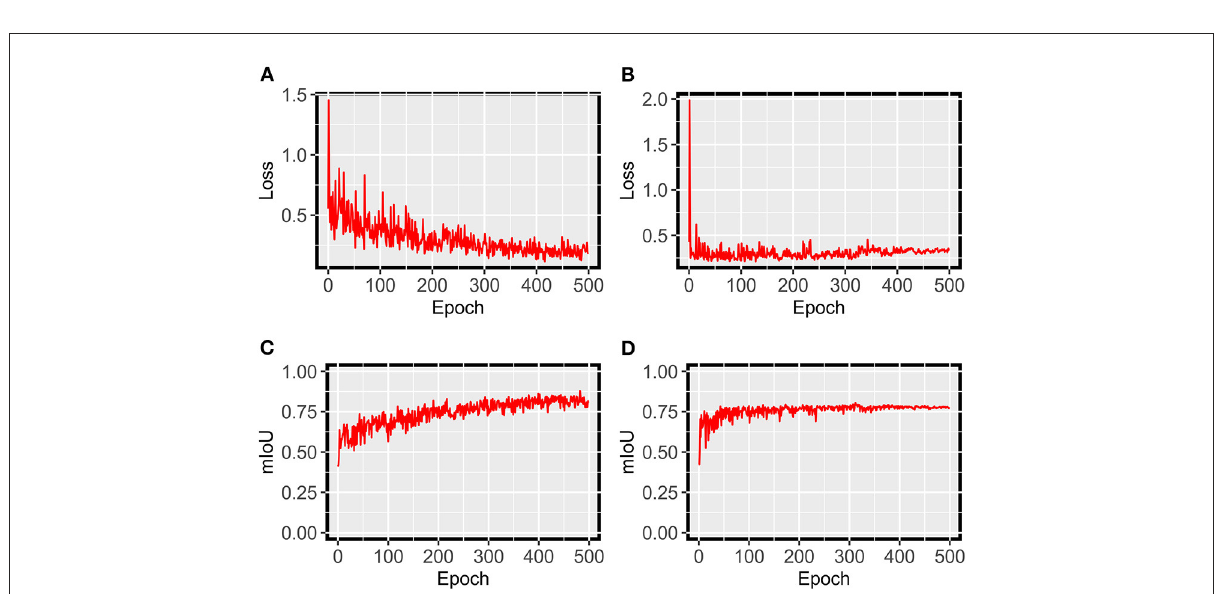
FIGURE10 HMASS training and validation process for PM infection segmentation dataset. Parameters were evaluated after each epoch. (A) Represents the cross-entropy loss evaluated on the training dataset. (B) Represents the cross-entropy loss evaluated on the validation dataset. (C) Represents the mIoU evaluated on the training dataset. (D) Represents the mIoU evaluated on the validation dataset.